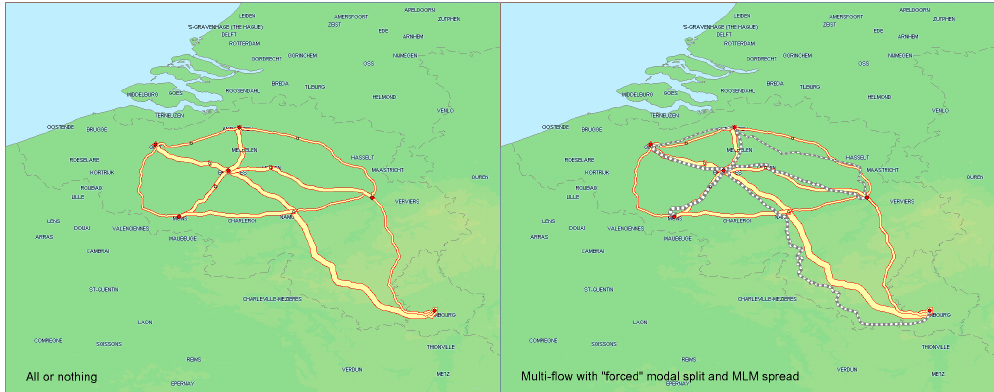
Figure 10. Sample assignments of an OD